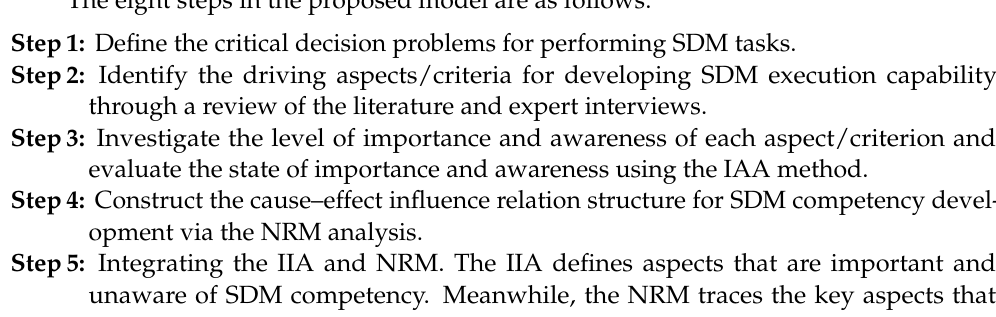
Figure 1. The SDM competency development based on the IAA-NRM approach. The eight steps in the proposed model are as